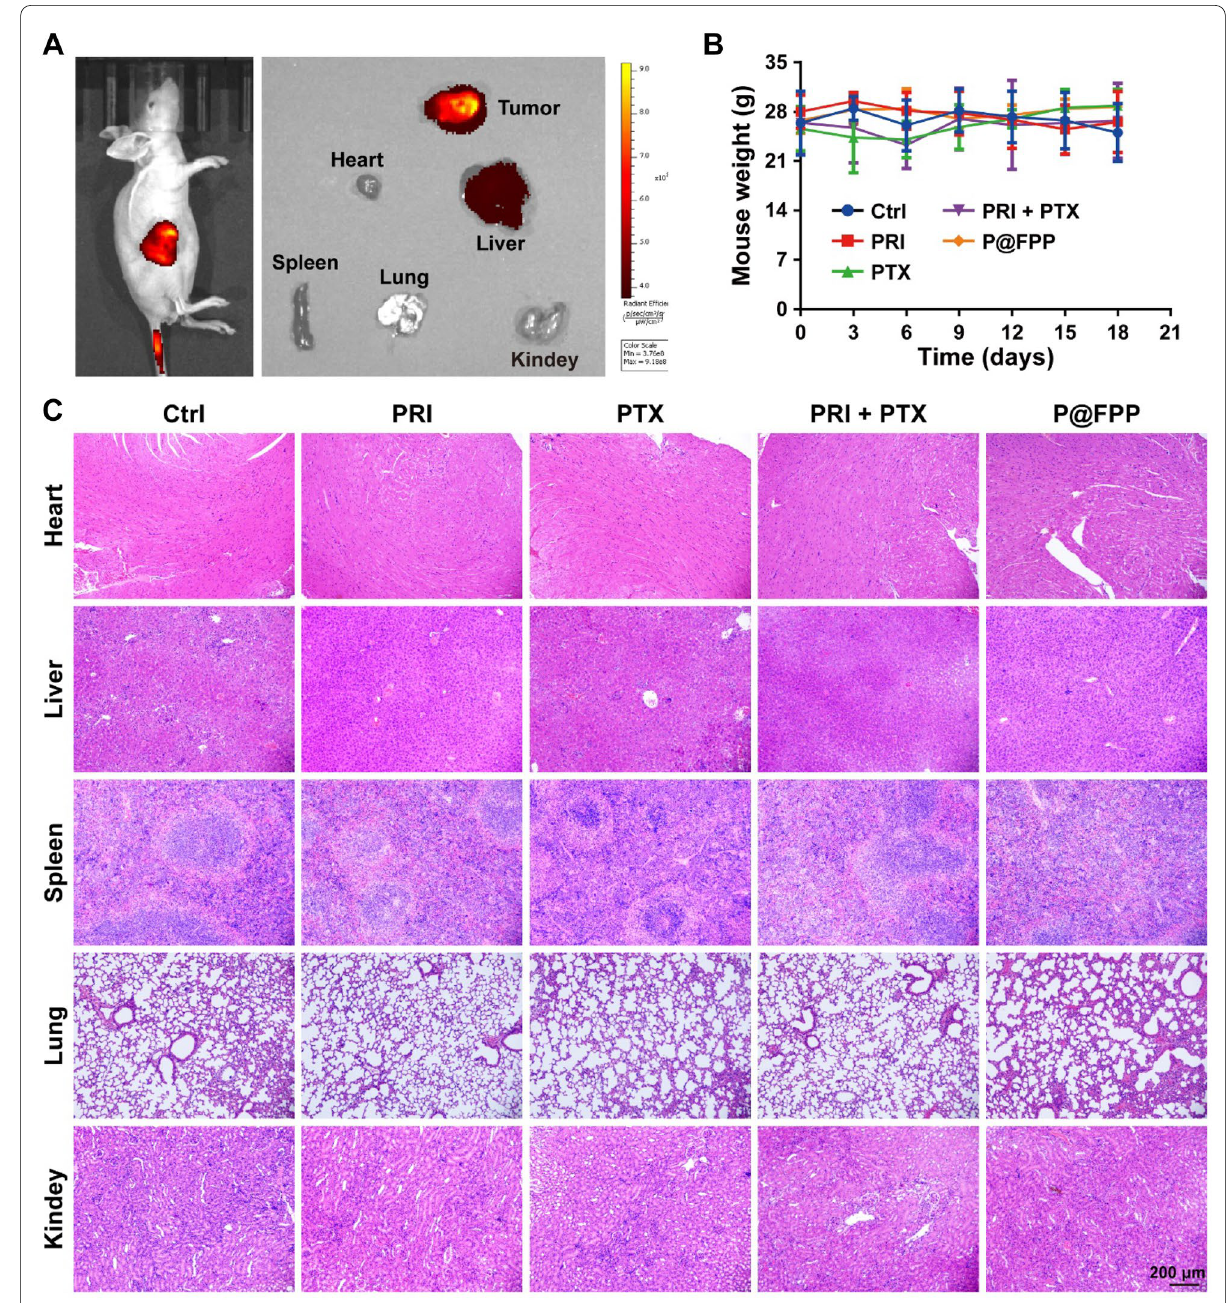
Fig. 9 In vivo biosafety evaluation of P@FPP NMs. A In vivo fluorescence imaging after intravenous injection with the ICG@FA-PEG-PTX (I@FPP) NMs at 4 h. B Body weight curves of A549 tumor-bearing mice with different treatments. C Representative images of H&E staining of major organs of tumor-bearing mice. Scale bar: 200